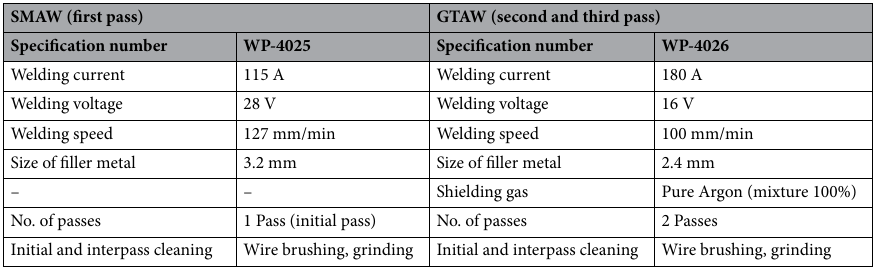
Table 2. Welding process